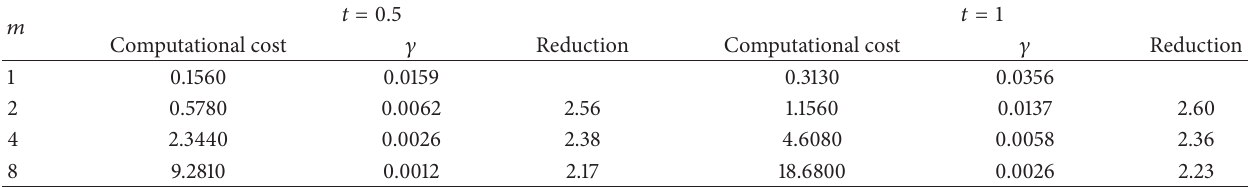
Table 1: Error estimate in maximum norm when 𝐷(𝑥) = 1 .